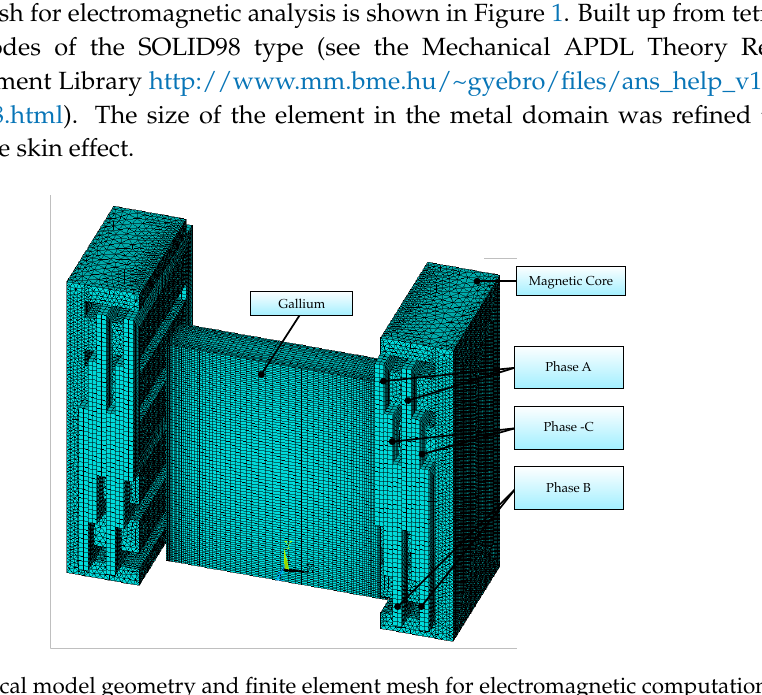
Figure 1. Numerical model geometry and finite element mesh for electromagnetic